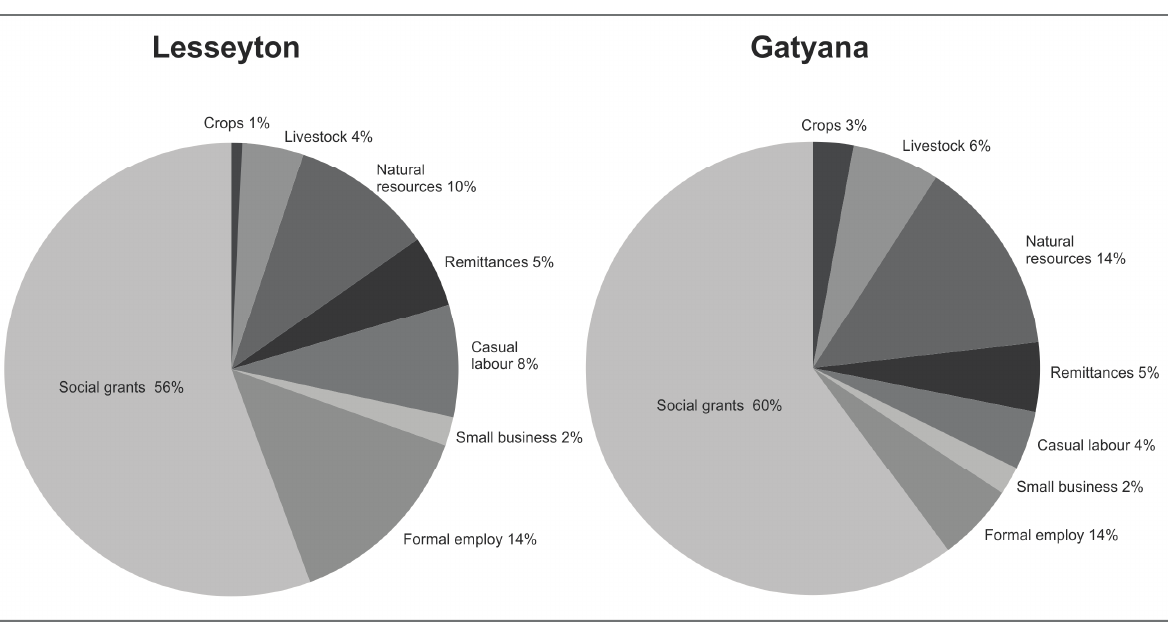
Figure 2. Average income shares from different livelihood sources across all households (n = 340) in Lesseyton and Gatyana (Source: Stadler 2012, unpublished thesis